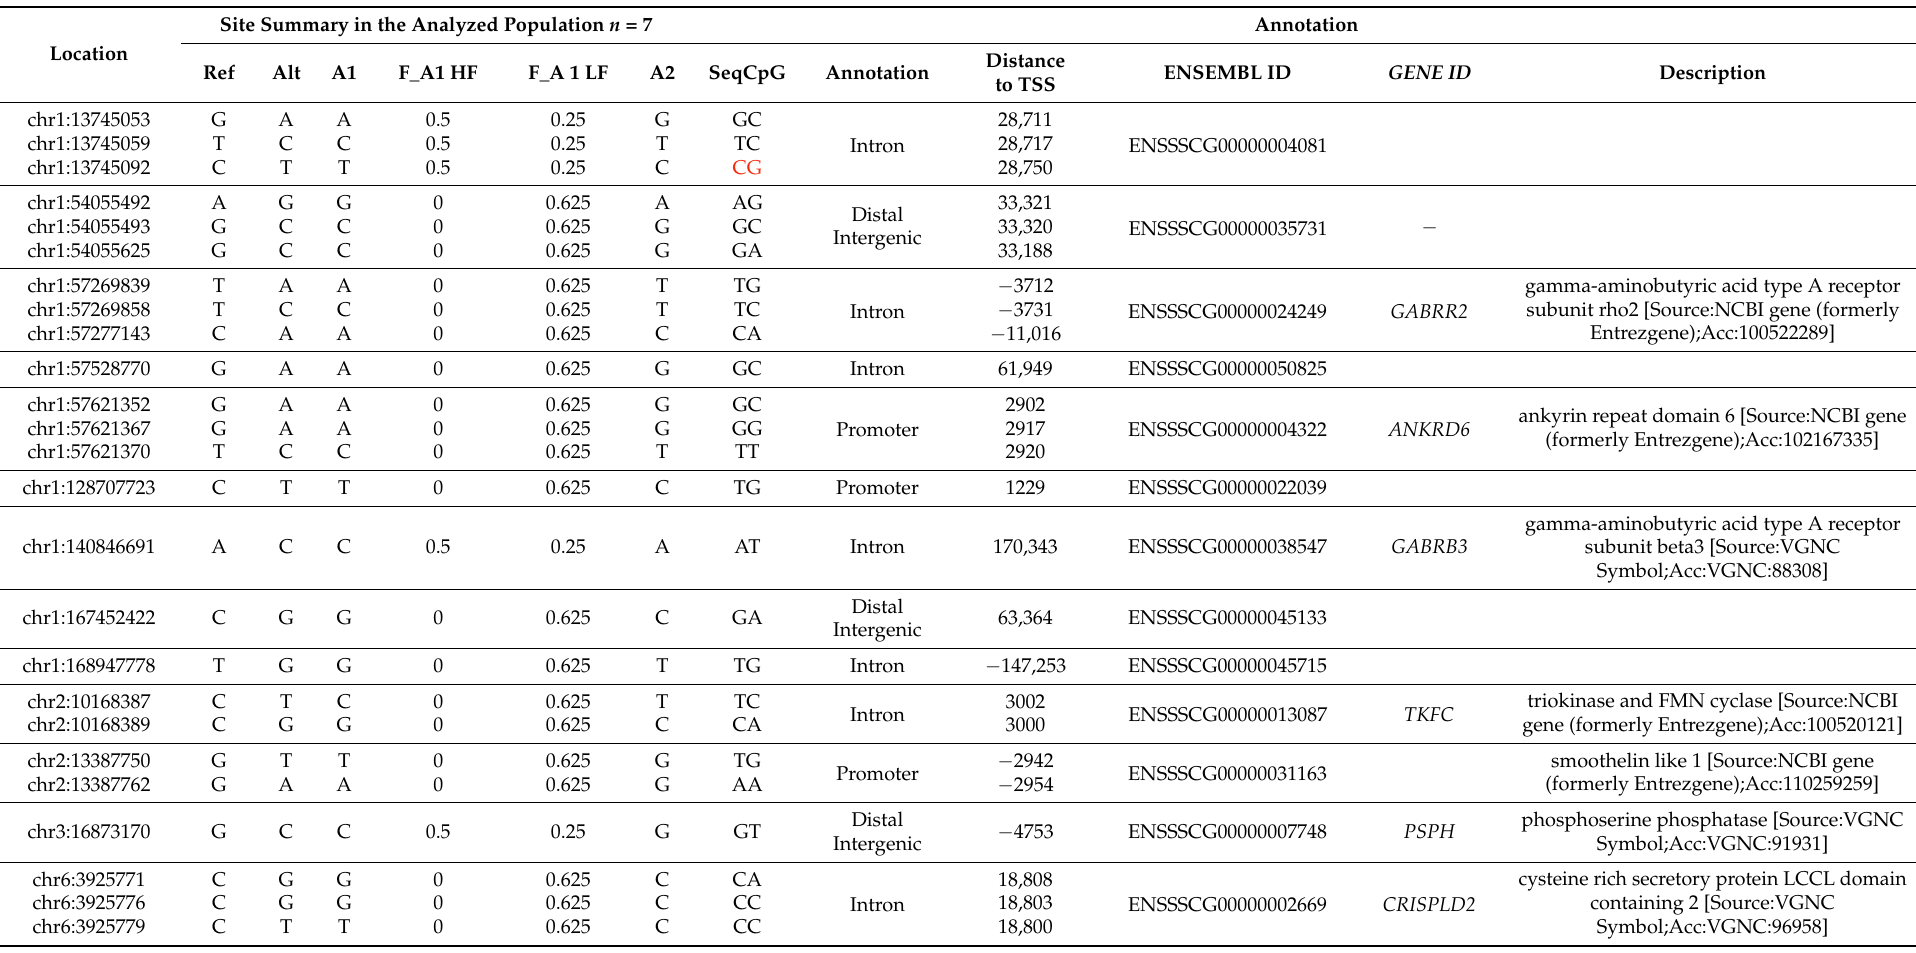
Table 2. Genomic features and annotation of the TOP-SNPs identified between HF and LF boars using Genomic-Wide Association Studies (GWAS) (the CG seqCpG is marked in red). Site Summary in the Analyzed Population n = Location